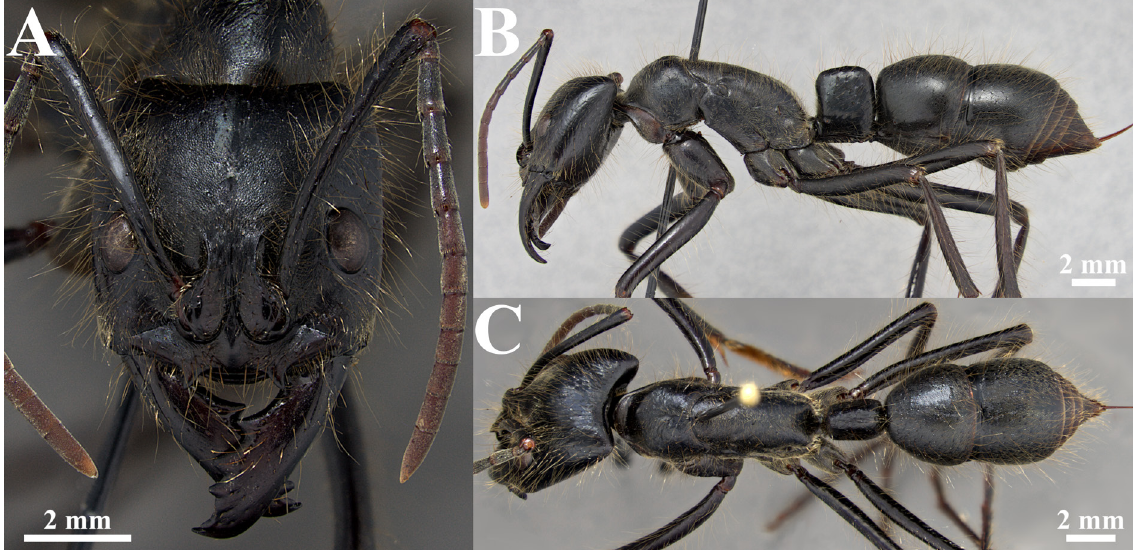
(specimen from Marituba, Pará, Brazil; CPDC). A . Full- ☿